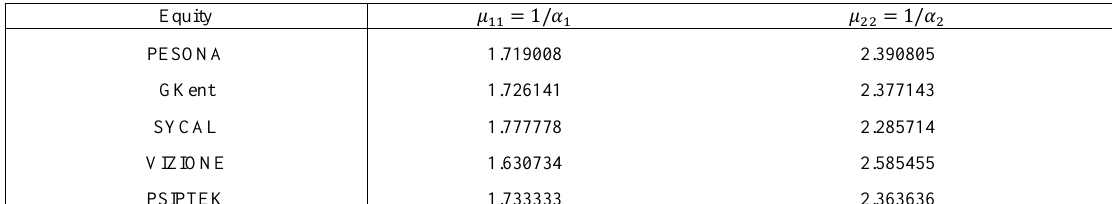
Table 6. Expected mean return time for respective stocks for two-state